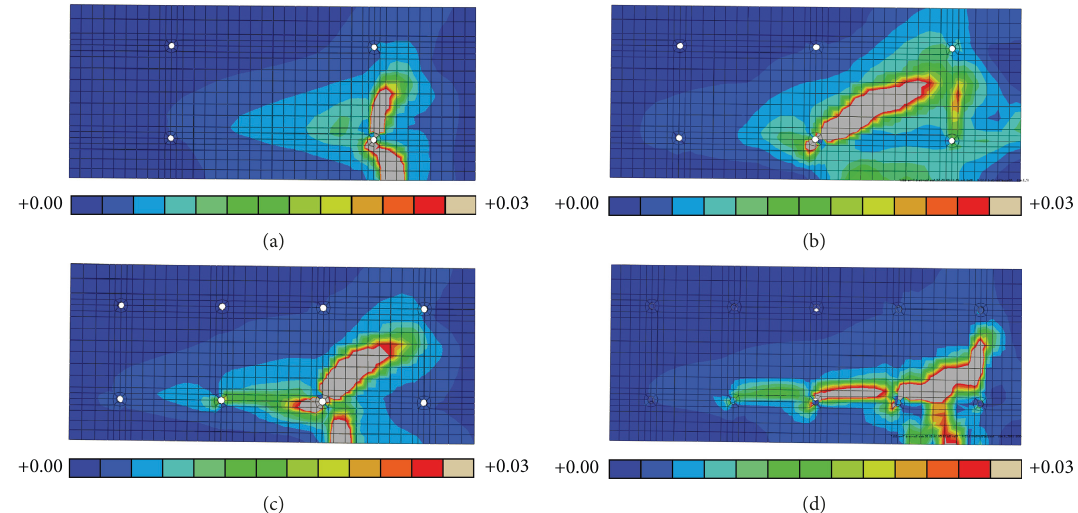
Figure 19: Strain at peak load of the panels with different numbers of bolts. (a) 4 bolts (B5). (b) 6 bolts (1.5F-6D12). (c) 8 bolts (1.5F-8D12). (d) 10 bolts